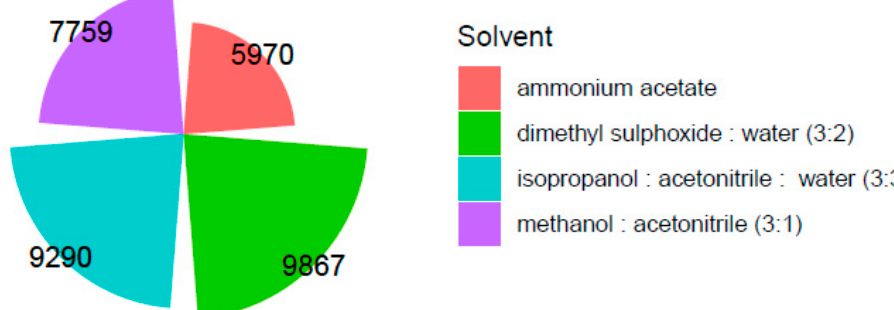
Figure 5. A comparison of the total number of compounds extracted from each of the four extrac- tion solvents.